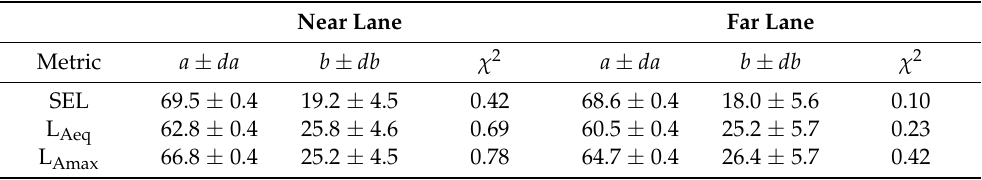
Table 3. Coefficients of the fit of data measured in T0. a and b units are dB(A).